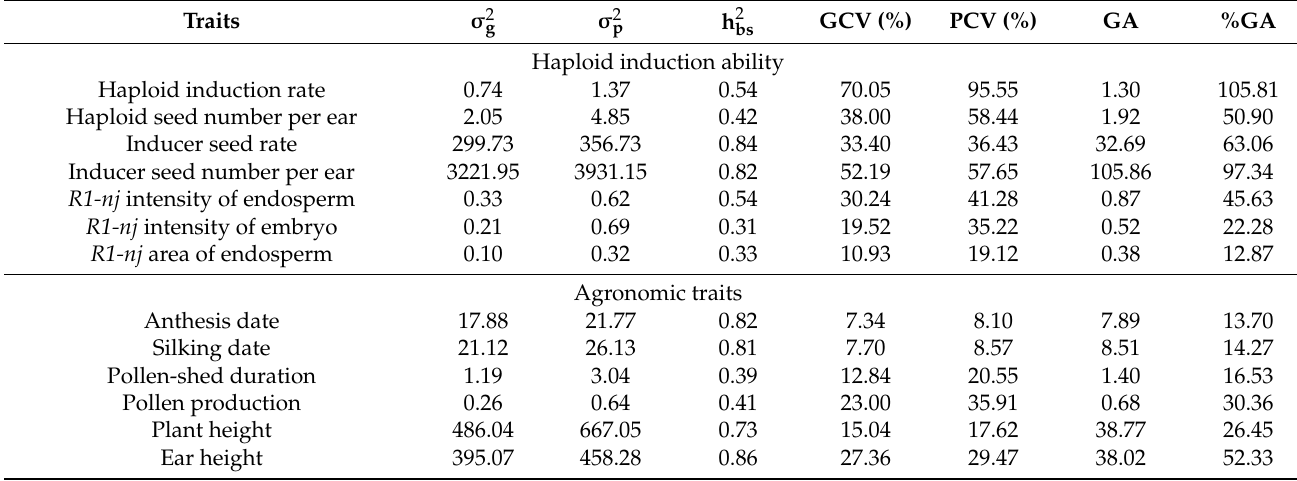
Table 2. Estimates of genetic parameters and predicted genetic gain of haploid induction ability and agronomic traits at 5% intra-family